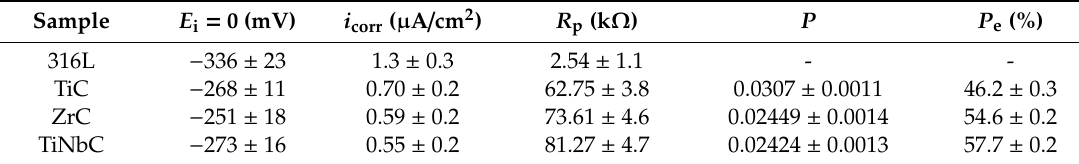
Table 4. The main corrosion parameters of uncoated and coated samples: E i = 0—corrosion potential; i corr —corrosion current density; R p —polarization resistance; P —porosity; P e —coatings protective e ffi ciency. The values represent the average of measurements performed on 3 di ff erent samples for each deposition conditions of